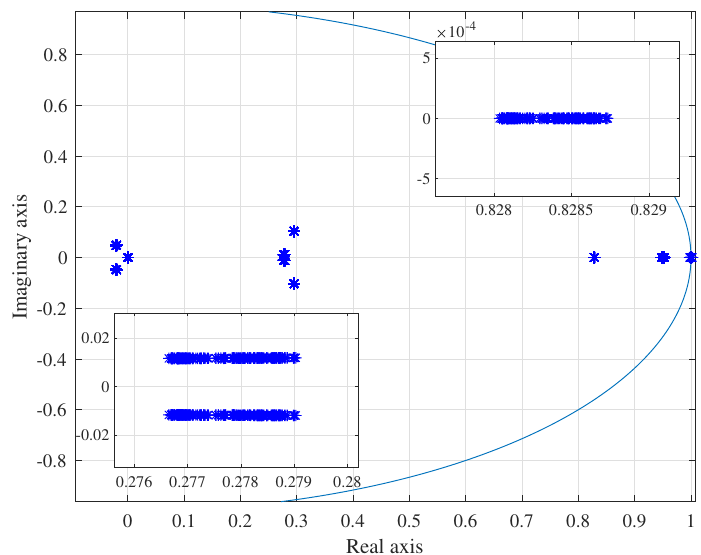
Figure 8. Floquet multipliers result from the variation R phaseC = [ 1.6 : 10 ]